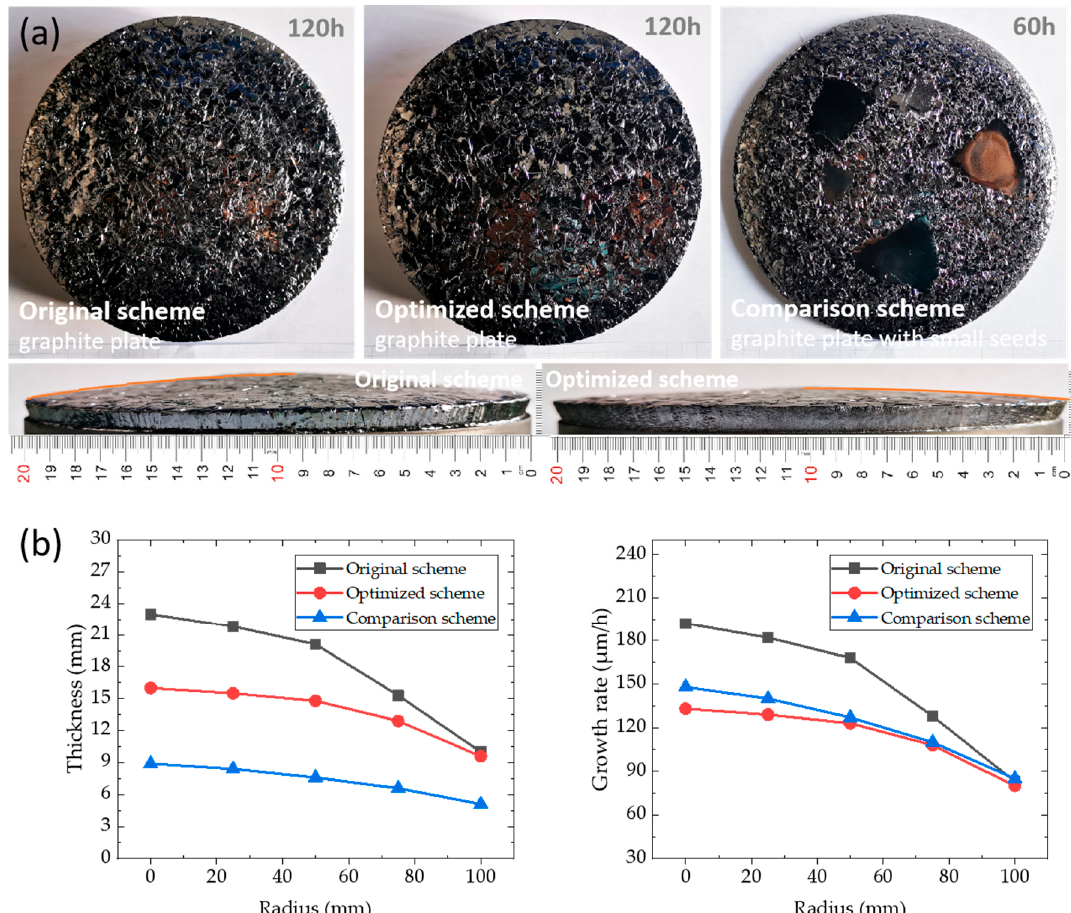
Figure 17. ( a ) 200 mm polycrystalline; ( b ) crystal thickness and growth rate.